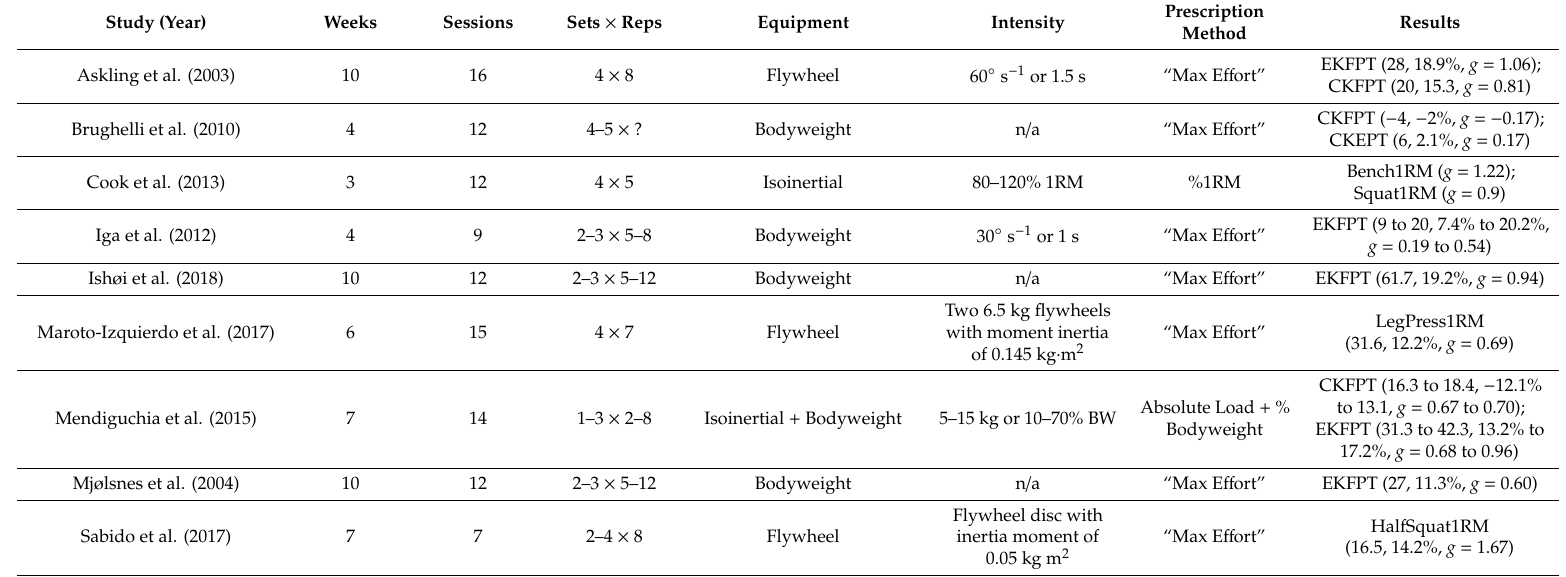
Table 3. Eccentric training intervention characteristics for strength